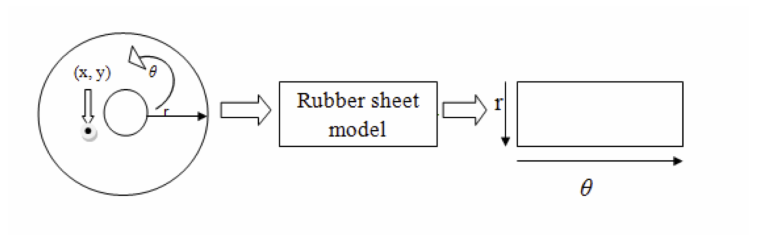
Figure 3. Daugman’s Rubber sheet model for the normalization of the iris.